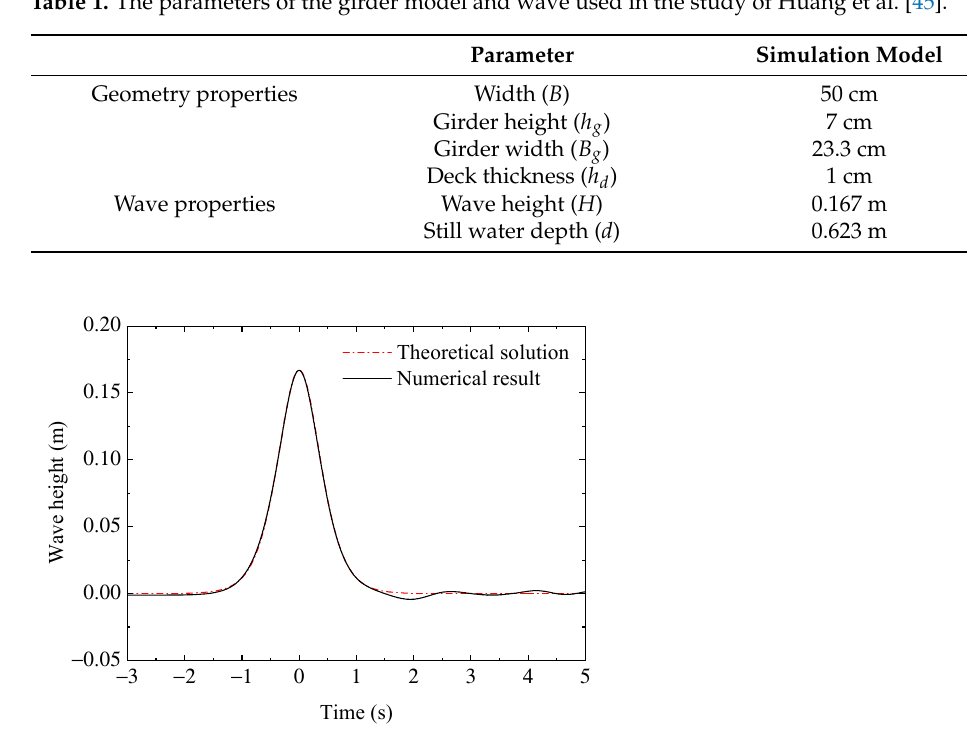
Figure 3. Comparison of numerical simulation and theoretical wave profiles of the solitary wave.